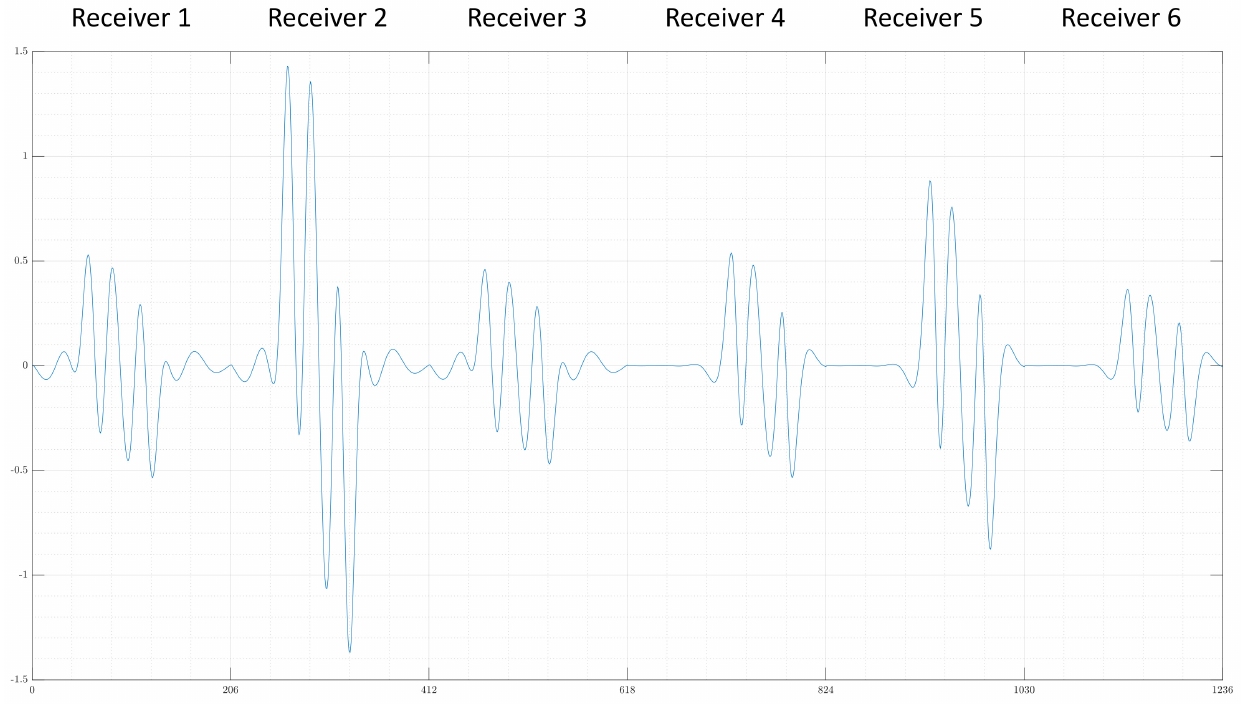
Figure 2. An example signal given by the forward problem, each receiver contributes 206 values to the total signal because unnecessary measuring points are cut from the original